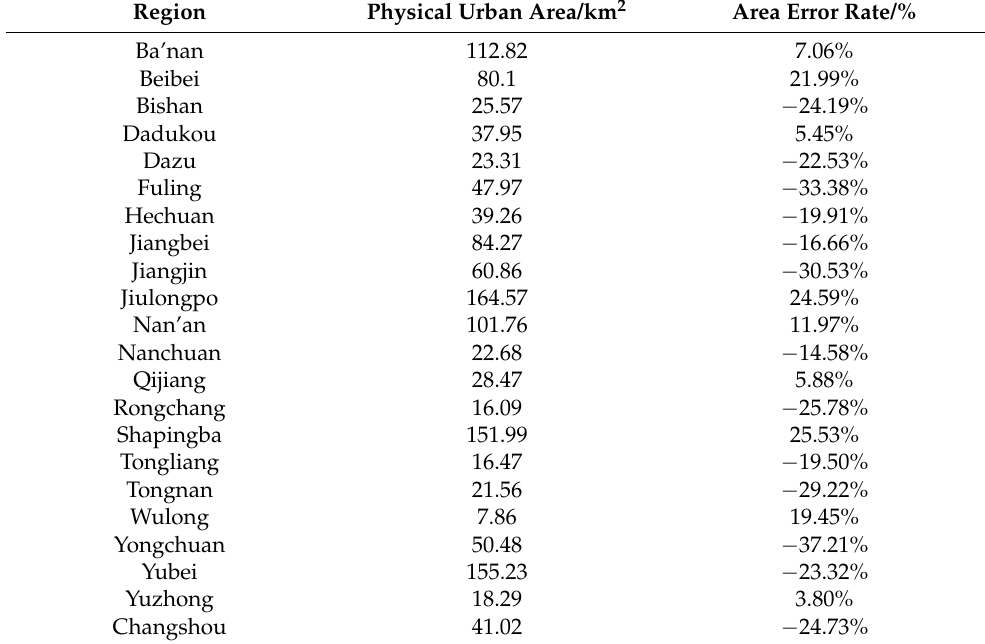
Table 8. Area error of 22